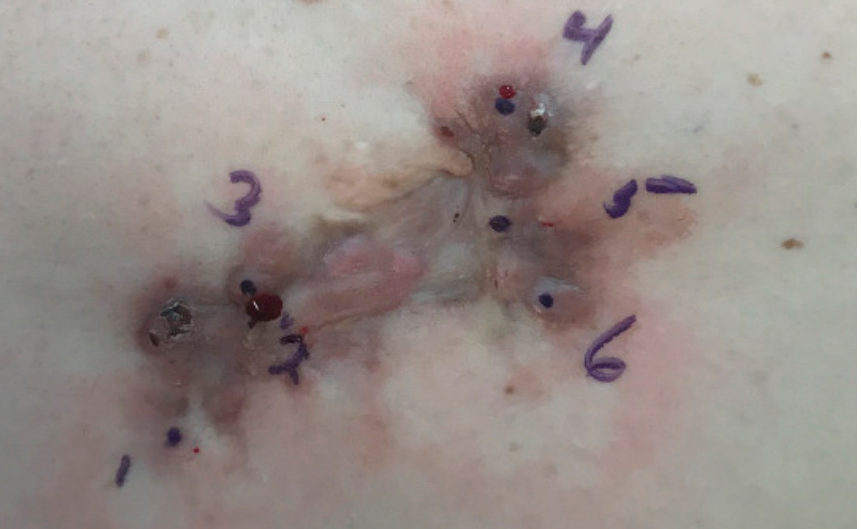
Figure 1. A plaque with irregular brown pigmentation.